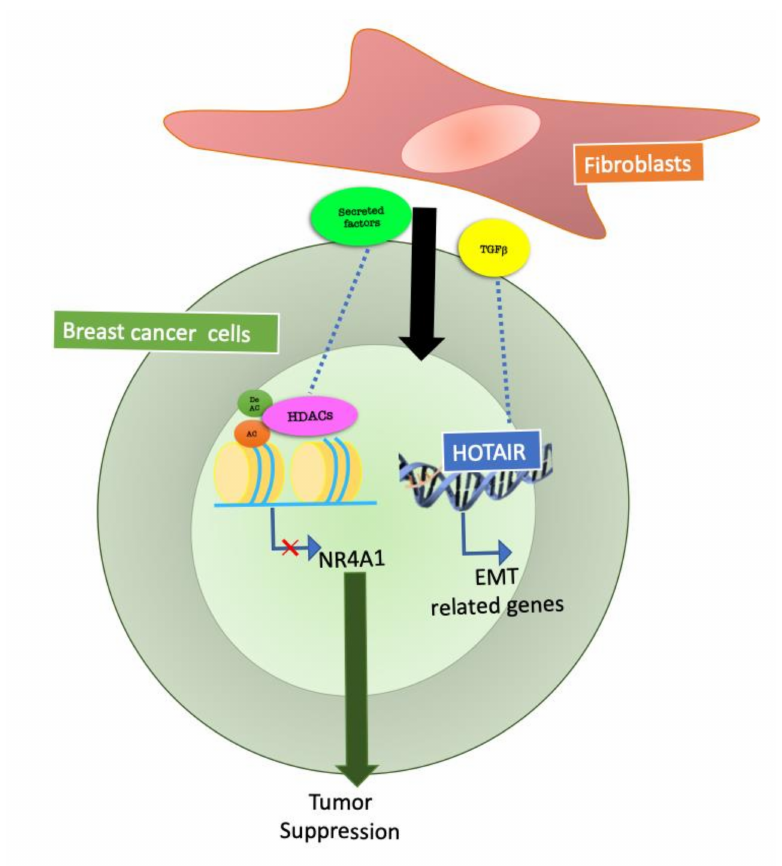
Figure 2. Epigenetic mechanisms at the basis of fibroblast communication with breast cancer cells. Fibroblasts are the most abundant stromal cells in breast cancer, and several studies have focused on fibroblasts and cancer cell communication. Fibroblasts, through secreted factors, can regulate HDACs (Histone deacetylases) and non-coding RNA activity in breast cancer cells and modulate tumour cell